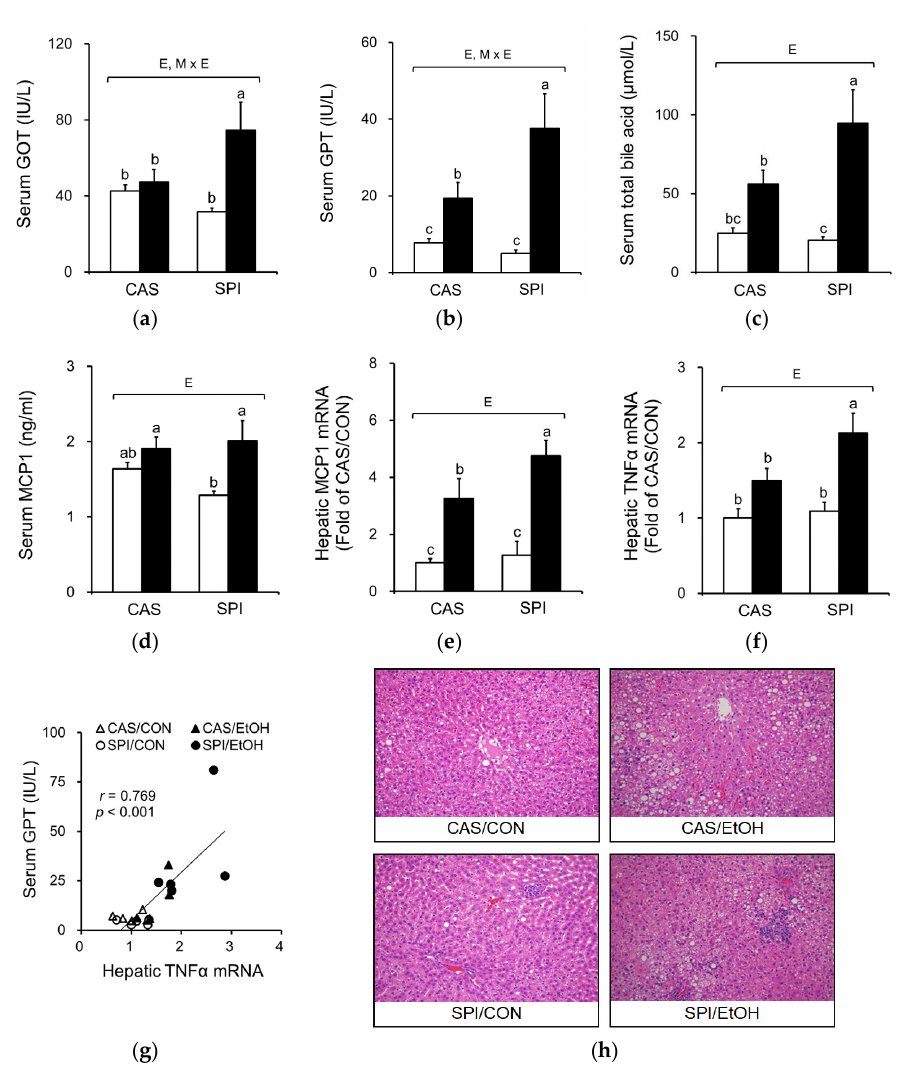
Figure 2. Effects of maternal diet on the liver injury in adult offspring fed an ethanol diet. ( a ) Serum glutamic-oxaloacetic transaminase (GOT) levels ( n = 8), ( b ) serum glutamic-pyruvic transaminase (GPT) levels ( n = 8), ( c ) serum bile acid levels ( n = 8), ( d ) serum monocyte chemoattractant protein-1 (MCP1) levels ( n = 7–8), ( e ) hepatic MCP1 mRNA levels ( n = 4–5), ( f ) hepatic TNF α mRNA levels ( n = 4–5), ( g ) correlation between hepatic TNF α mRNA levels and serum GPT levels, and ( h ) representative H&E staining of liver tissue sections ( n = 4). The mRNA levels were analyzed by real-time PCR and normalized to beta-actin (ACTB) as an endogenous control. Data are expressed as means ± SEM. Significant effects of maternal diet (M), offspring ethanol diet (E), and their interaction (M × E) were analyzed by two-way ANOVA ( p < 0.05). Means without a common superscript significantly differ based on post-hoc analysis ( p < 0.05). Pearson correlation coefficient, r , and p -value are indicated. Data that were not normally distributed were log-transformed before the statistical analysis. CAS, casein; SPI, low ‐ isoflavone soy protein isolate; CON, control; EtOH, ethanol.